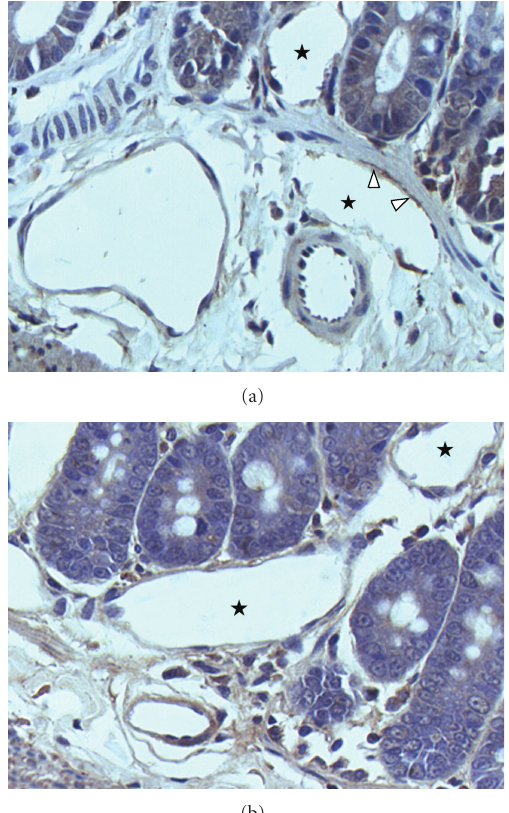
Figure 6: Intestinal lymphangiogenesis (a, b) is increased in rats with microsurgical extrahepatic cholestasis. (cid:2) indicates lymphatic vessels lumen, and arrows indicate stained lymphatic endothelium. Immunohistochemical staining with Prox-1 antibody ( ×